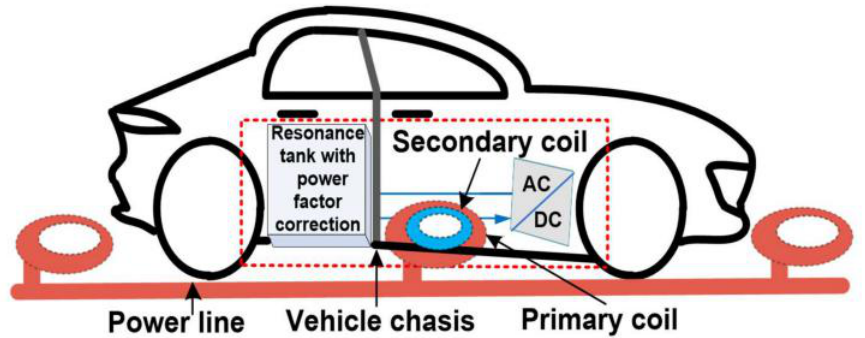
Figure 3. Block diagram for transverse inductive charging technique in vehicles.